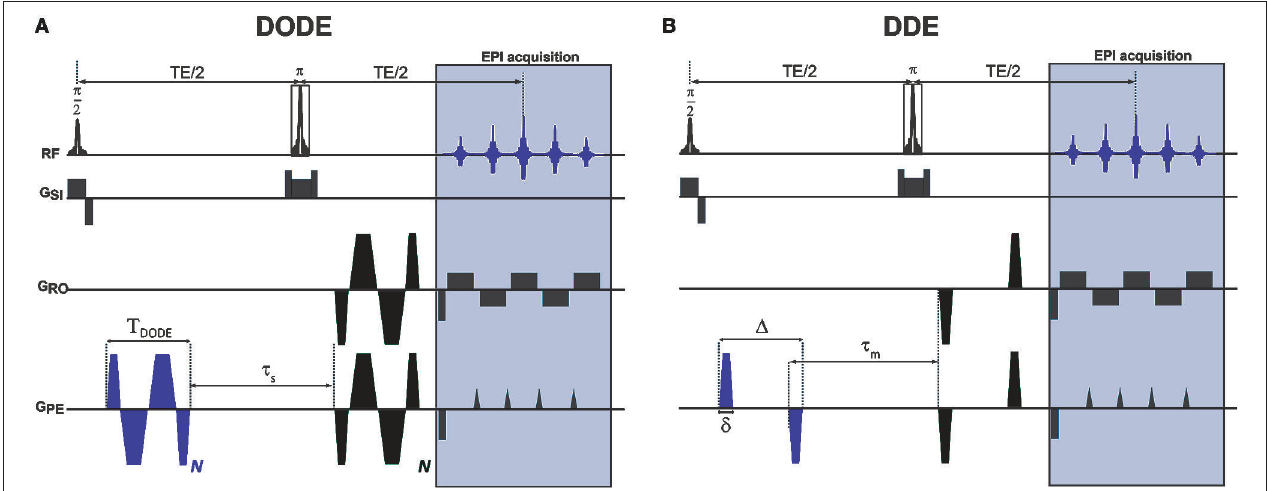
FIGURE 1 | Diffusion MRI pulse sequences used in this study. (A) DODE and (B) DDE weightings were overlaid on a basic SE-EPI sequence. The diffusion gradient orientations are independent and can vary in any of the axes, the particular instantiation here represents one particular case where G 1 is oriented along the PE axis and G 2 is at an angle in the PE-RO plane. Other than the relative orientations that varied, identical waveforms were used for the two diffusion